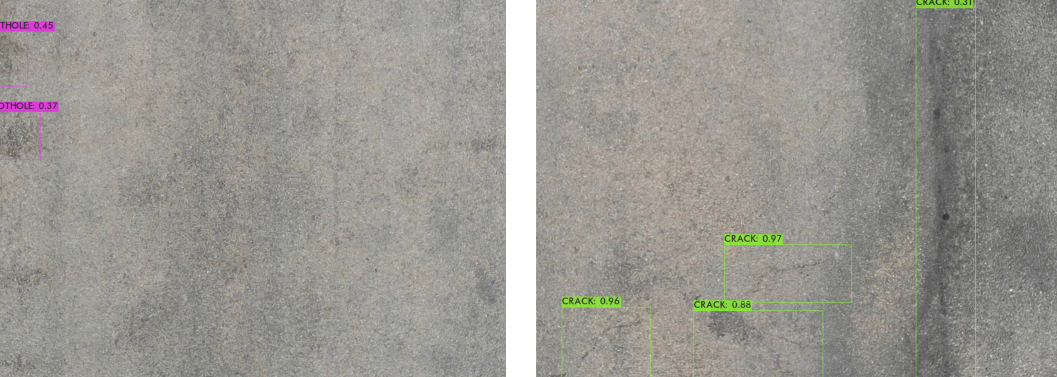
Figure A1. Detection results.